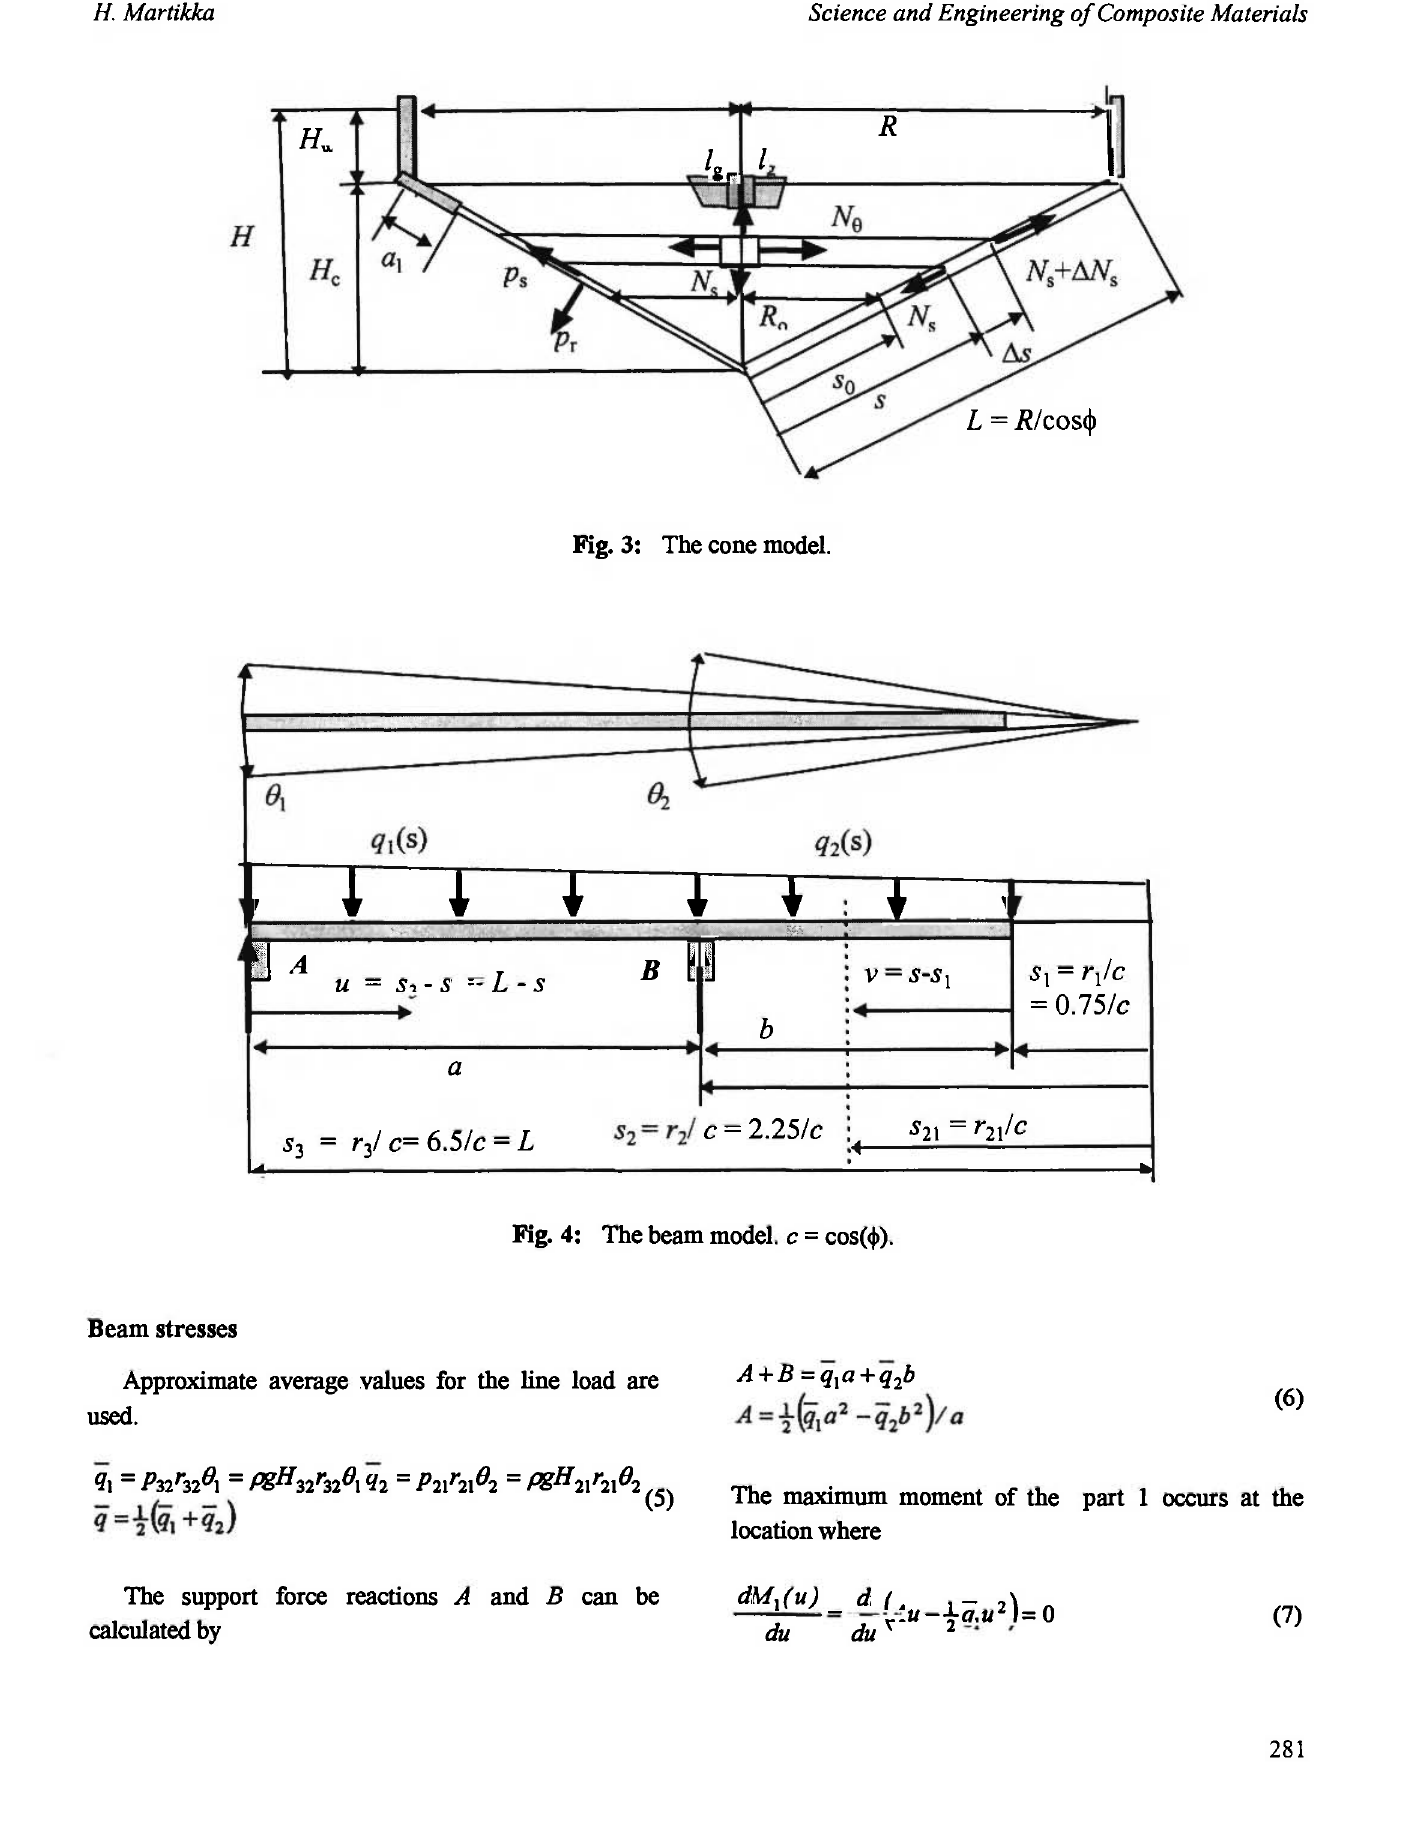
Fig. 3: The cone model.